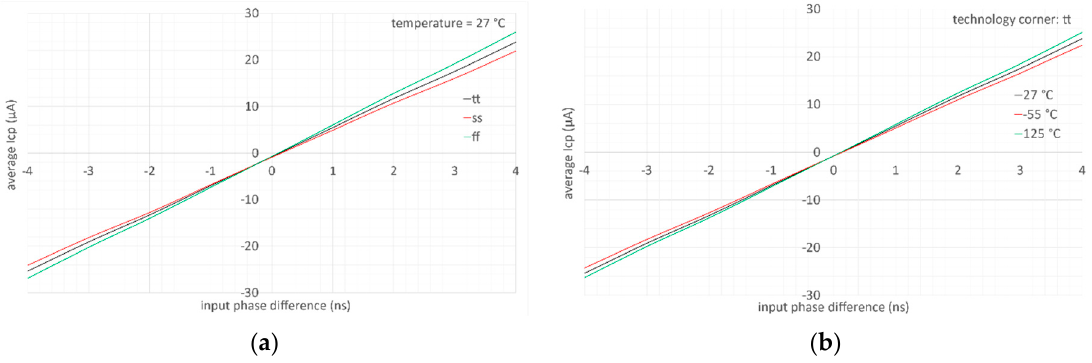
Figure 17. PFD/CP characteristic for different technology corners at 27 °C ( a ) and different Figure 17. PFD / CP characteristic for di ff erent technology corners at 27 ◦ C ( a ) and di ff erent temperatures temperatures in typical case ( b ). in typical case ( b ).